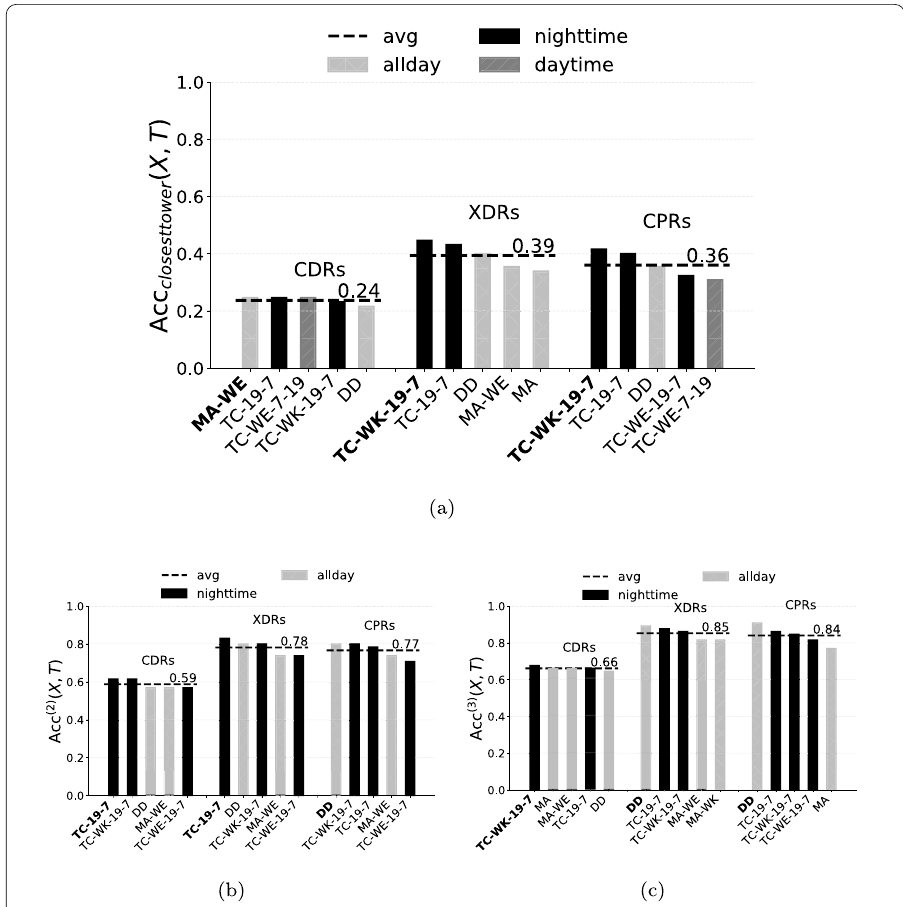
Figure 6 ( a ) Home detection accuracy of the top five HDAs considering just the nearest tower to the user’s actual home as ground truth. Dark bars indicate algorithms based on nighttime records, dark grey bars indicate those based on daytime records, light grey bars indicate those using records during all day. The dashed line indicates the average accuracy across the top five HDAs. In the x axis, we highlight in bold the best combination of stream and HDA. ( b ) Home detection 2-accuracy and ( c ) 3-accuracy, for the top five HDAs for each stream